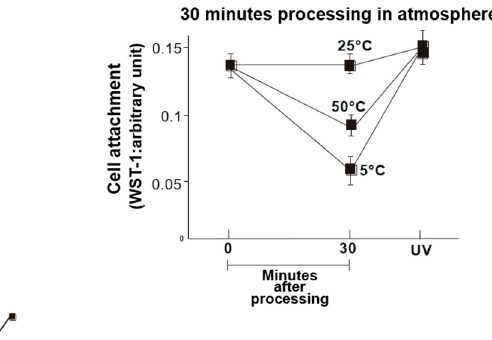
Figure 6. Relationship between initial cell attachment and hydrophilicity: ( a ) overall ( R = − 0.35), ( b ) at 5 °C ( R = − 0.77), ( c ) at 25 °C ( R = − 0.88), and ( d ) at 50 °C ( R = − 0.70).